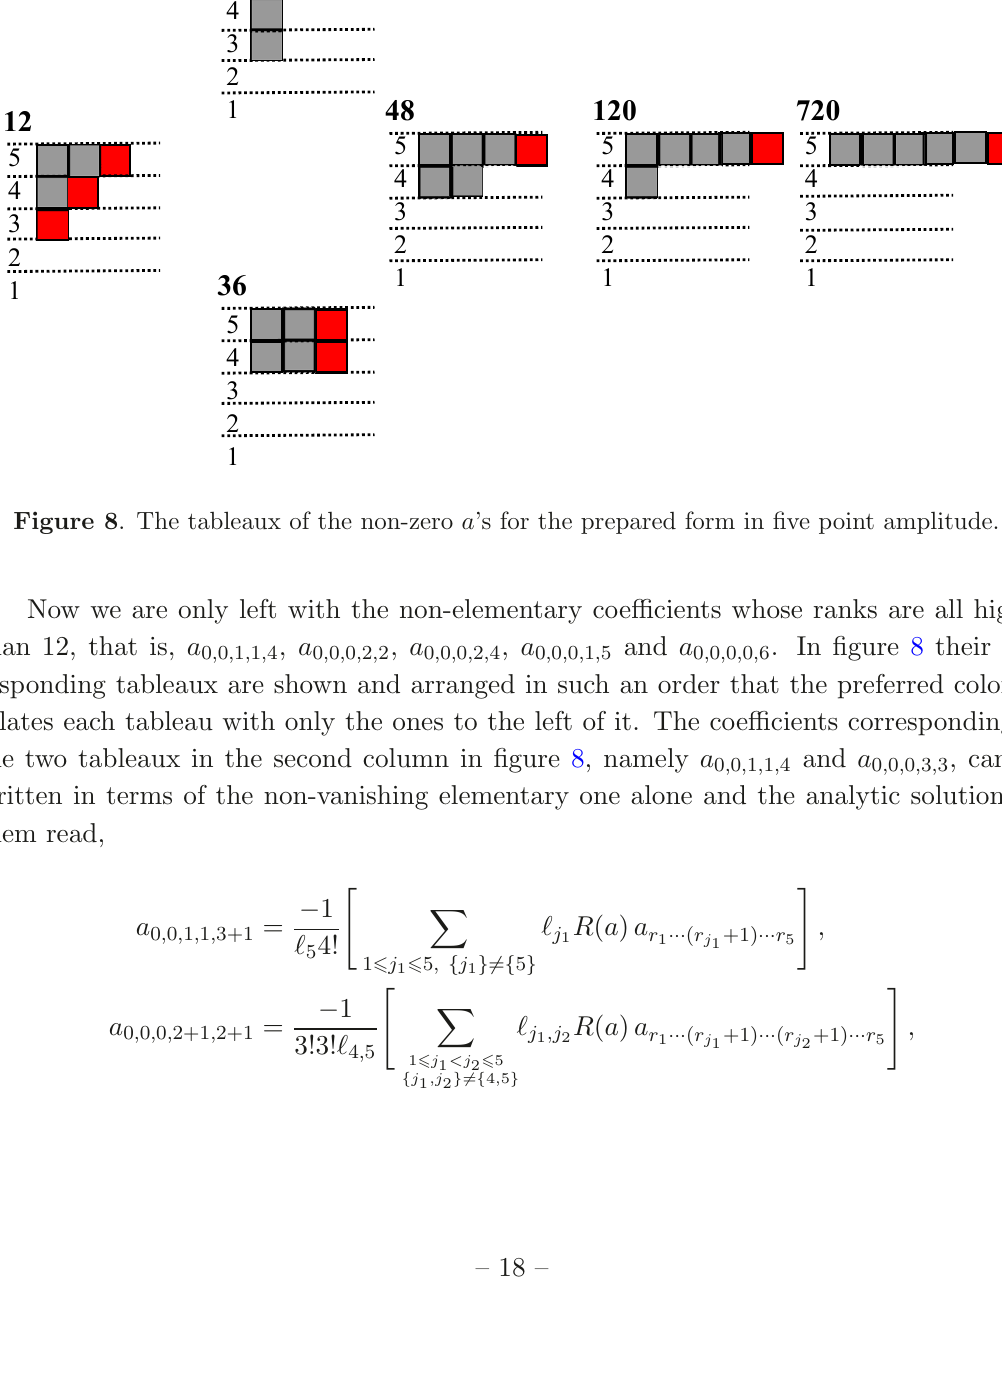
2 , 1 , 1 , 1 , 1 , a 2 , 2 , 1 , 1 , 0 , a 3 , 2 , 1 , 0 , 0 .